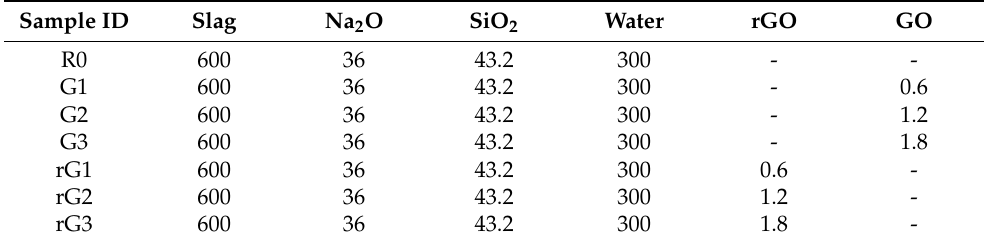
Table 3. Mixing proportions of